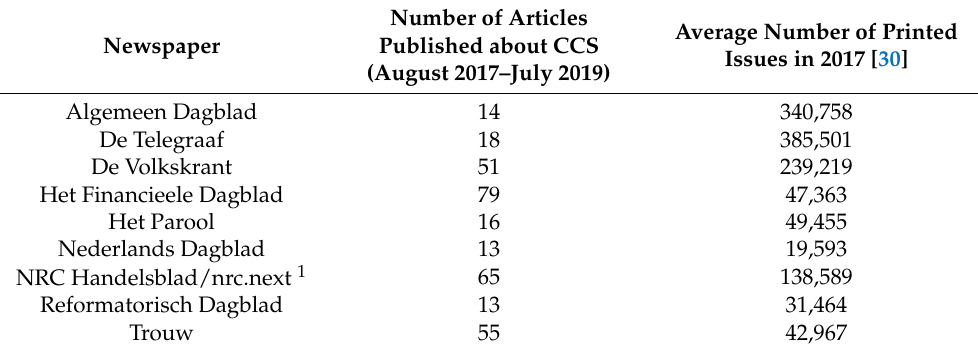
Table 1. The number of articles published about CCS in each newspaper during the investigated period and the average number of printed issues for the selected newspapers in